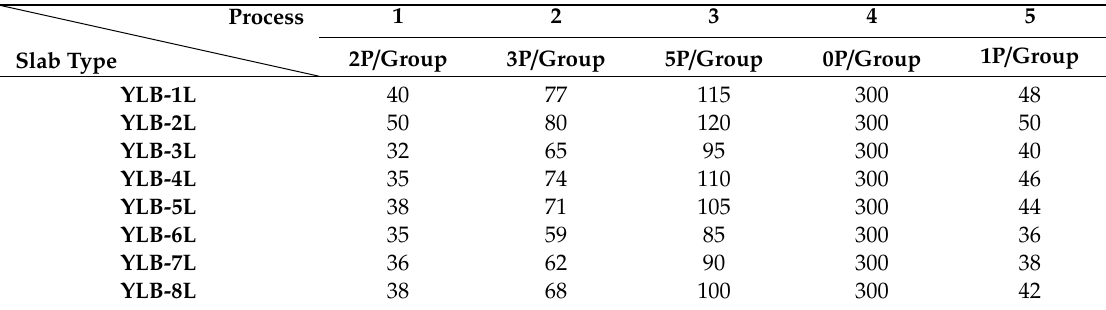
Table 3. Operation times of di ff erent types of precast slabs